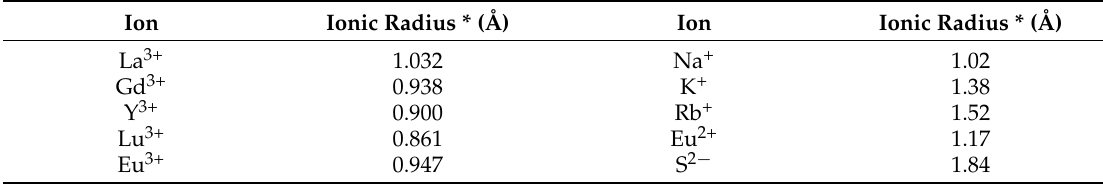
Table 2. Structural parameters of all discussed ALnS 2 sulfides.